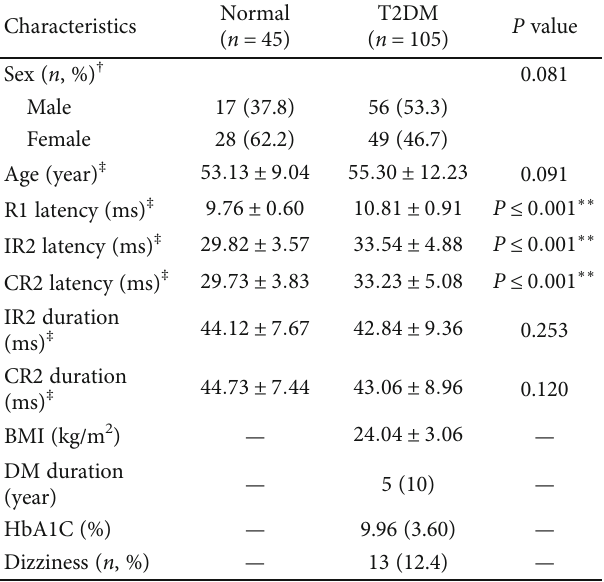
Table 1: Clinical characteristics of the study participants. Characteristics